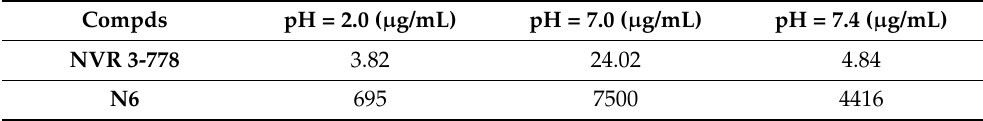
Table 2. Water solubility of N6 and NVR 3-778 at different pH.